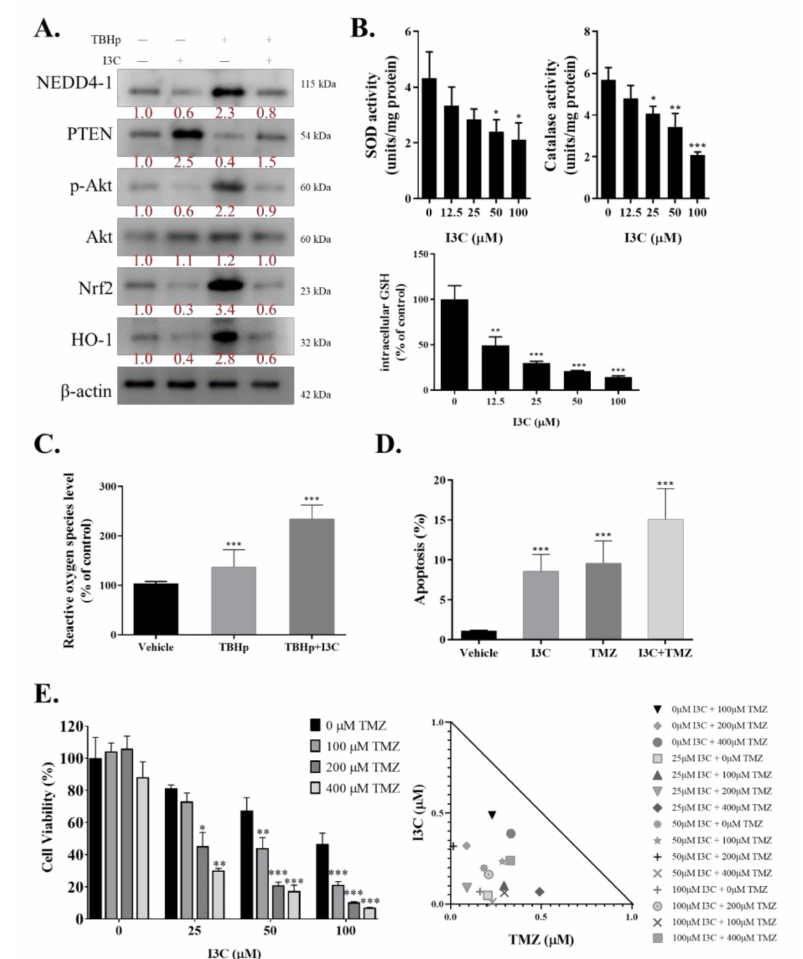
Figure 5. I3C inhibits NEDD4-1 expression and represses temozolomide-resistant GBM cell line Nrf2-induced antioxidant response. ( A ) Protein expression of NEDD4-1, PTEN, p-AKT, AKT, NRF2, and HO-1 was evaluated after inducing oxidative stress with TBHp and treatment with I3C. ( B ) Effect of various doses of I3C on antioxidant enzyme activity in U87MGR cells. ( C ) Flow cytometry analysis of TBHp-induced ROS formation in U87MGR cells with/without I3C treatment using the ROS-sensitive fluorometric probe DCFDA. Relative ROS production in all cells tested normalized to TBHp + vehicle group. ( D ) Cell apoptosis rate assay using annexin V/PI staining of U87MGR cells treated with I3C and/or temozolomide. ( E ) Cell viability assay of U87MGR cells treated with I3C and/or temozolomide. Graph bars are the mean ± SEM of three independent experiments. * p < 0.05, ** p < 0.01, *** p <